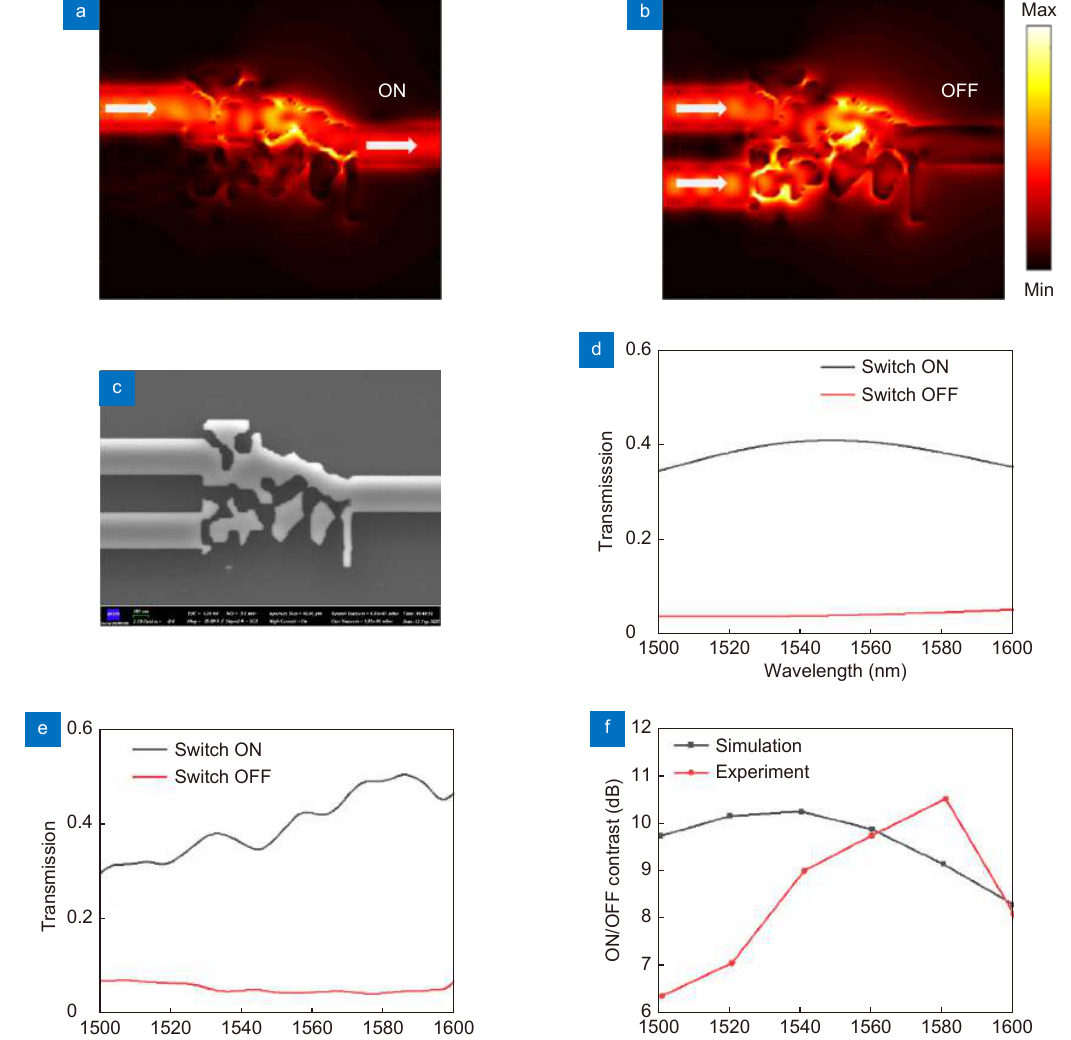
Fig. 2 | Characterization of the all-optical switch. ( a ) The “ON” state of normalized intensity distribution in the x - y plane from theoretical calcu- lation. ( b ) The “OFF” state of normalized intensity distribution in the x - y plane from theoretical calculation. ( c ) Scanning electron microscopy (SEM) image of the all-optical switch. The size of the optimized area was 2 μm×2 μm. ( d ) Simulation results of the transmission of all-optical switch. ( e ) Experiment results of the normalized transmission of all-optical switch. ( f ) The simulation and experiment results of the all-optical switch ON/OFF